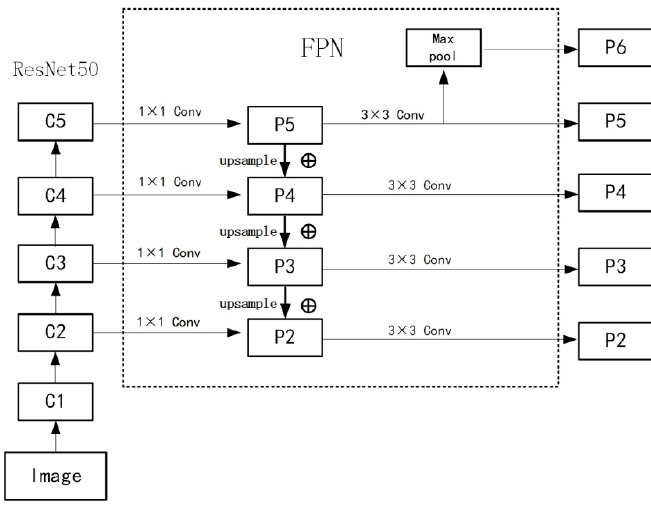
Figure 9. Combination of feature maps at different levels.